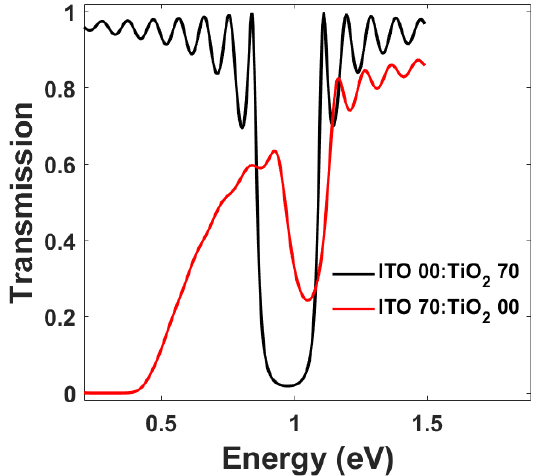
Figure 2. Light transmission spectrum of a SiO 2 nanoparticle/TiO 2 nanoparticle photonic crystal (black curve) both with a filling factor of 0.7, and light transmission spectrum of a SiO 2 nanoparticle/ITO nanoparticle photonic crystal (red curve) both with a filling factor of 0.7.